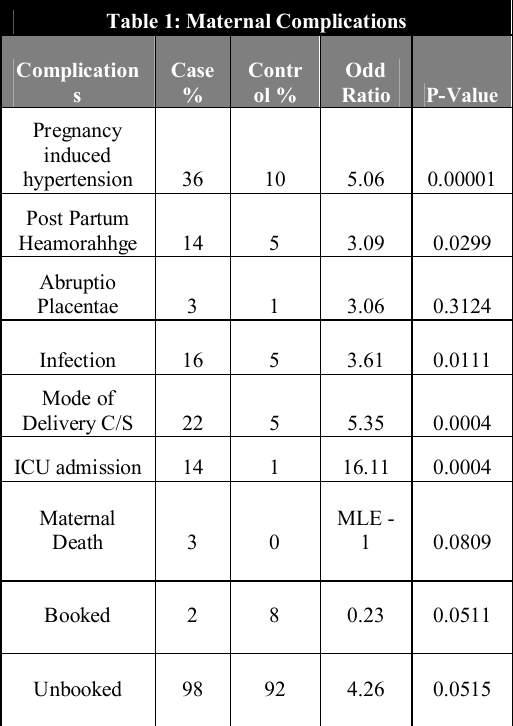
Table 1: Maternal